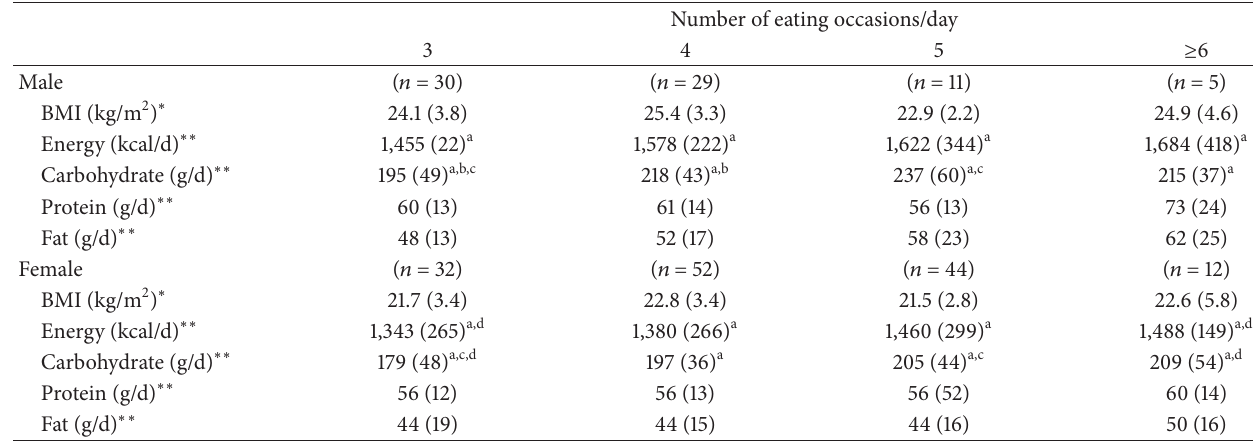
Table 7: Comparison of BMI and macronutrient intakes for different eating